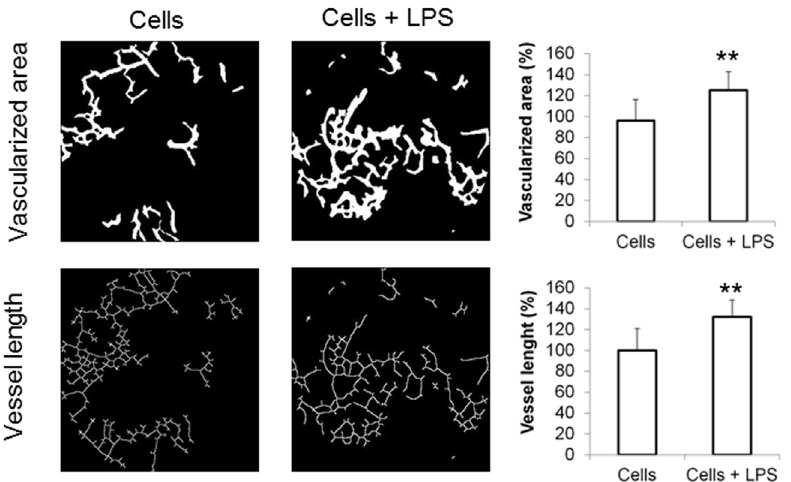
Fig 5. Vascularization of the scaffold in vivo . One week after scaffold implantation in a full-thickness wound neovascularization was detected by transillumination and quantification was performed by digital segmentation. Results showed significantly higher vascularized areas and vessel length in the presence of LPS activated SDSC (n = 10) compared to untreated SDSC-seeded scaffolds (n = 10). * p < 0.05, ** p < 0.001.